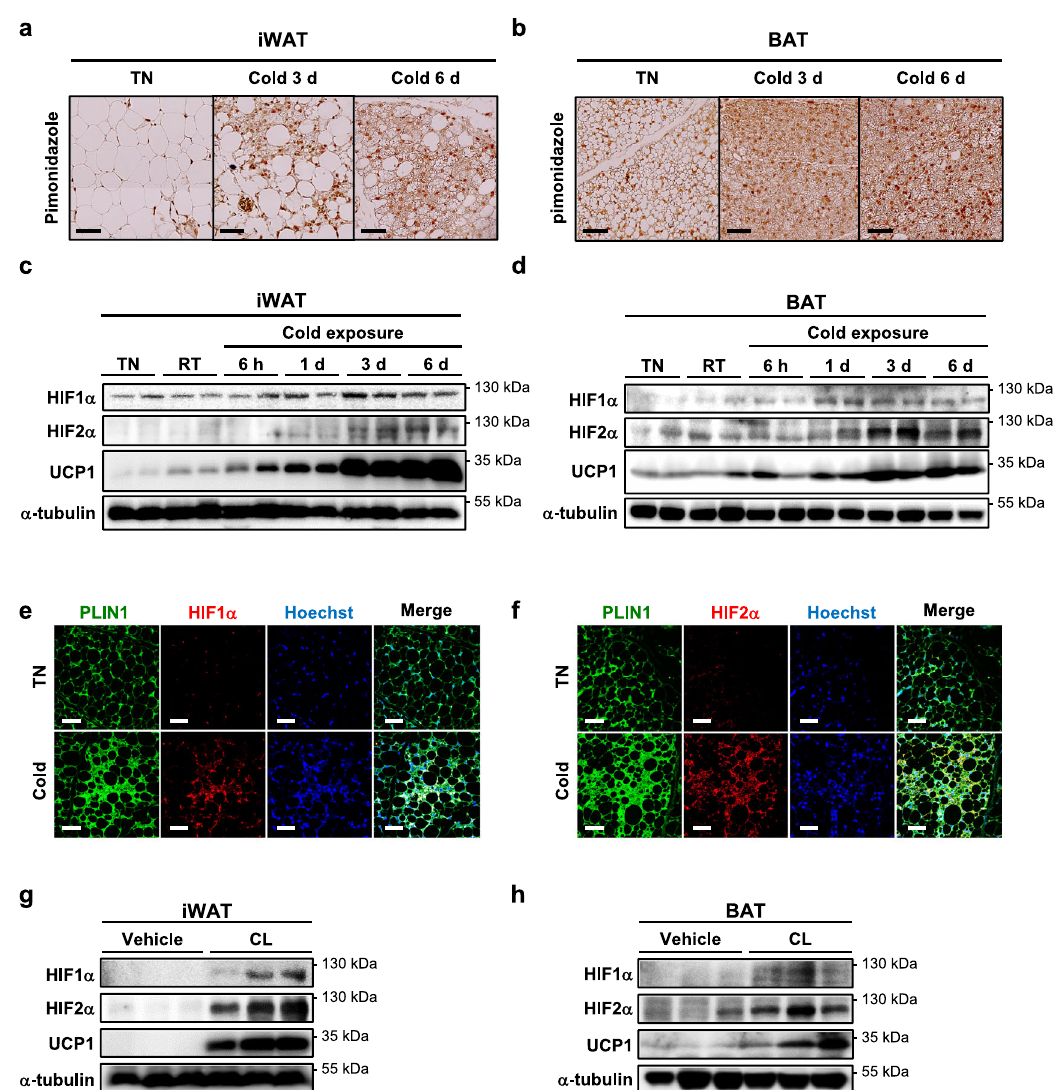
Fig. 1 Cold exposure induces HIF α expression in thermogenic adipose tissues. a , b Immunohistochemistry of ( a ) iWAT and ( b ) BAT sections upon TN or cold exposure using an anti-pimonidazole antibody and DAB staining. Scale bars, 50 μ m. c , d Western blot analysis of HIF α and UCP1 (loaded 50 μ g for iWAT and 10 μ g for BAT) in c iWAT and d BAT upon TN (30 °C), RT (22 °C), or cold exposure (4 – 6 °C). e , f Immuno fl uorescence images of iWAT sections upon TN or cold exposure (3 days) using anti-PLIN1 (green) and e anti-HIF1 α or f anti-HIF2 α (red) antibodies with Hoechst (blue) staining. Scale bars, 50 μ m. g , h Western blot analysis of HIF α and UCP1 in g iWAT and h BAT at TN upon daily CL administration (0.5 mg/kg, 4